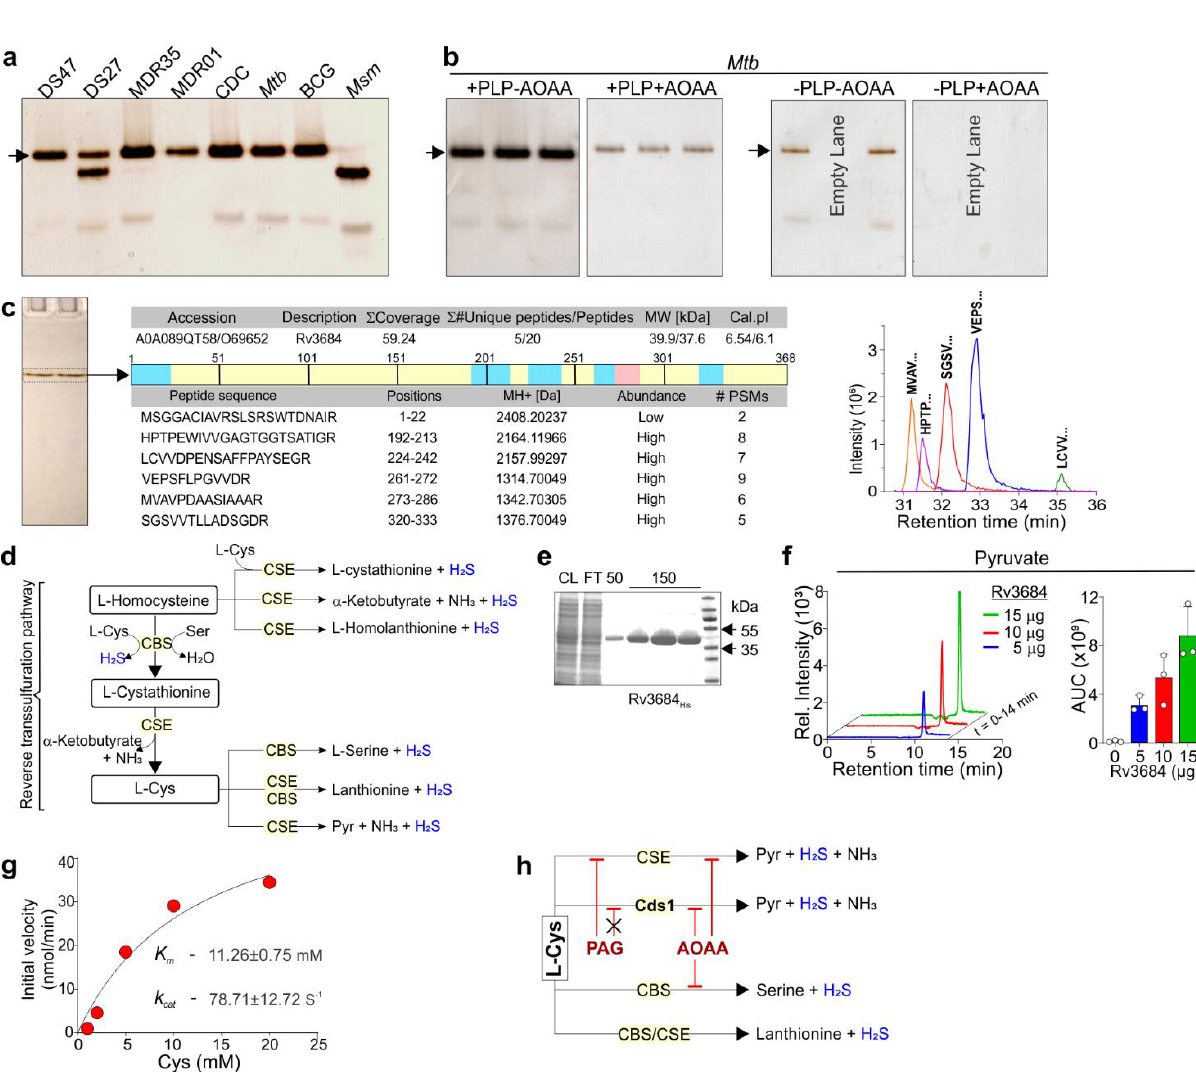
Figure 2. Identification of H 2 S-producing enzymes in Mtb . ( a ) Equal quantities of mycobacterial lysates were resolved on a native polyacrylamide gel (PAGE) and assayed for H 2 S production by an in-gel BC assay. The arrow indicates the predominant H 2 S-producing enzyme, upper band, for most mycobacterial species except for Msm. ( b ) The effect of PLP and AOAA on the production of H 2 S in Mtb H37Rv lysate using an in-gel BC assay. All lanes were loaded with equal amounts of lysate ( n = 2–3). ( c ) Identification of Rv3684 from Mtb lysate resolved by native PAGE. Trypsin-digested peptide fragments of Rv3684 were identified using LC-MS/MS. The locations of the observed peptide fragments (blue and pink regions within the full-length peptide map) and their amino acid sequences are shown. PSM: peptide spectrum matches; MH+ (Da): protonated, monoisotopic mass of the peptide. Retention time of each LC-MS/MS identified peptide of Rv3684 are shown ( right panel, Figure 2c). ( d ) Schematic showing H 2 S-generating enzymes and their reactions in the reverse transsulfuration pathway. ( e ) SDS-PAGE analysis of eluted fractions of purified His-tagged Rv3684 expressed in E. coli . ( f ) LC-MS/MS identification and quantification of pyruvate from Rv3684 using L-Cys (10 mM) as a substrate, ( n = 3). ( g ) Michaelis–Menten plot of the initial reaction velocity as a function of Cys concentration used to determine the K m and k cat of purified Rv3684. H 2 S-producing activity of purified Cds1 (Rv3684) using a BC assay, ( n = 4). ( h ) Proposed catalytic activity of Cds1 using Cys as a substrate. Representative experiments are shown; each experiment was repeated at least twice. Data represent the mean ± SD from the indicated n (number of replicates per data set).